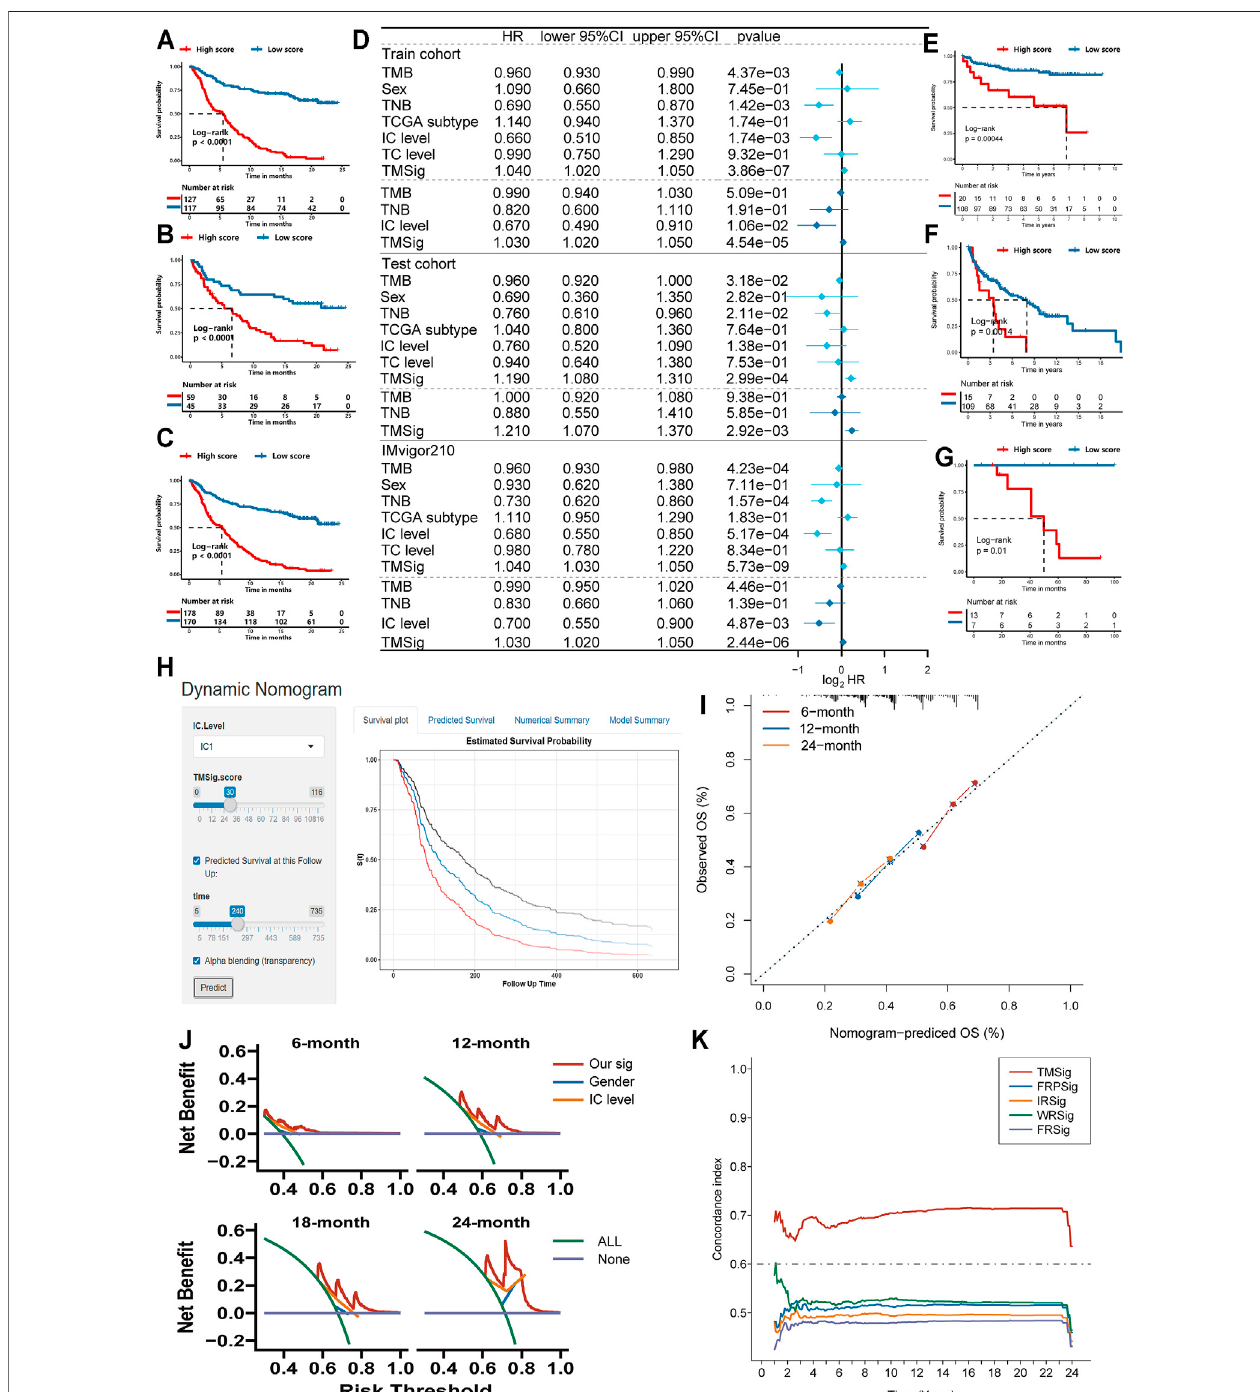
FIGURE3| ExploringtheclinicalpracticevalueofTMSig. (A) Kaplan-Meiercurvesforoverallsurvival(OS)ofpatientsfromthetraincohort. (B) Kaplan-Meiercurves forOSofpatientsfromthetestcohort. (C) Kaplan-MeiercurvesforOSofpatientsfromtheIMvigor210cohort. (D) IndependentprognosticanalysisofTMSig. (E) Kaplan- Meier curves for OS of patients from the GSE32548 cohort. (F) Kaplan-Meier curves for OS of patients from the GSE48075 cohort. (G) Kaplan-Meier curves for OS of patientsfromtheUTUCcohort. (H) Dynamicnomogramforclinicalpractice. (I) Calibrationcurveanalysis. (J) Thedecisioncurvesanalysis. (K) Thec-indexofTMSig compared with other signatures.